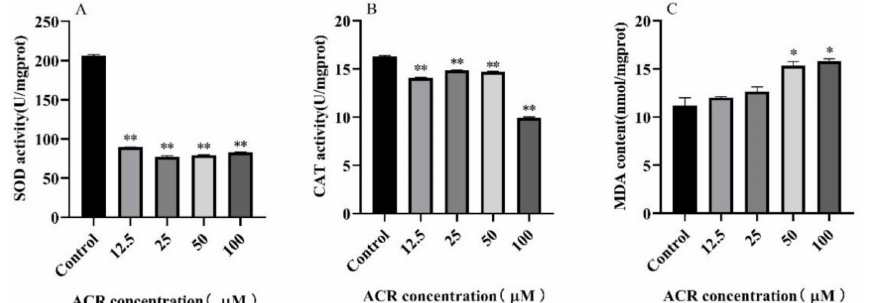
Figure 6. Effect of ACR exposure (12.5, 25, 50, and 100 µ M for 48 h) on the antioxidant enzyme activities, namely ( A ) SOD activity, ( B ) CAT activity, and malondialdehyde content ( C ) MDA content, of C. elegans . Values are means ± SD. *Compared with the control group, p < 0.05; ** compared with the control group, p <